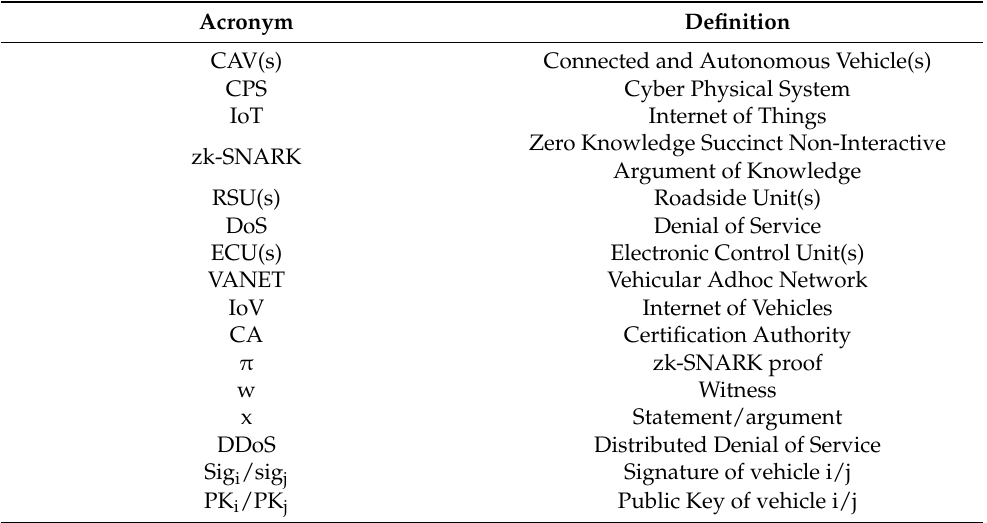
Table 1. List of